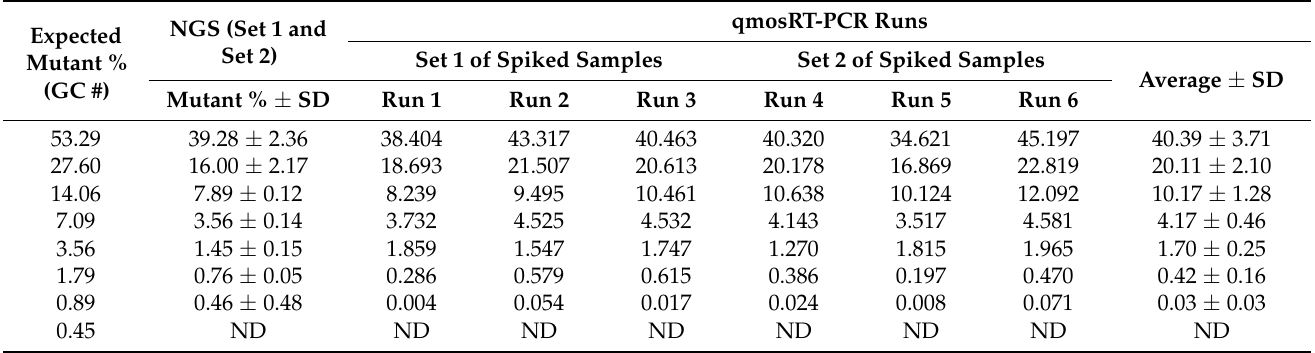
Table 4. Quantification of nOPV2-c1_295 mutants in the virus-spiked samples by qmosRT-PCR assay using plasmids as reference standards.